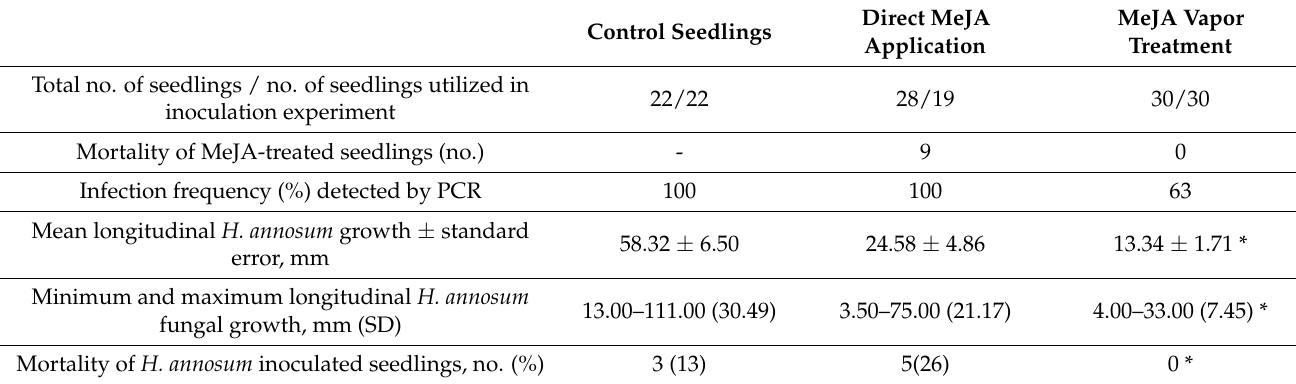
Table 1. Mean longitudinal H. annosum growth in sapwood of P. sylvestris and infection frequency, based on positive PCR results. Total no. of seedlings / no. of seedlings utilized in inoculation experiment